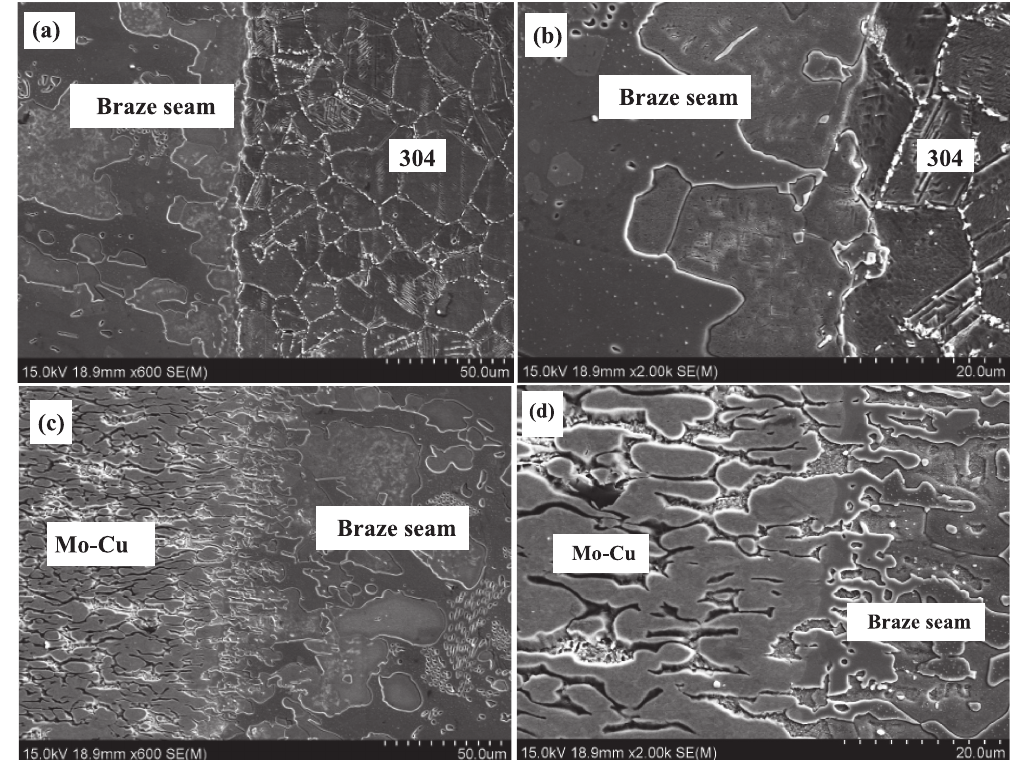
Fig. 3: Interfacial characteristics of Mo-Cu/304 stainless steel brazed joint: (a) interface beside 304 stainless steel, (b) Ni-Fe solid solution, (c) interface beside Mo-Cu composite, (d) Ni-Cu solid